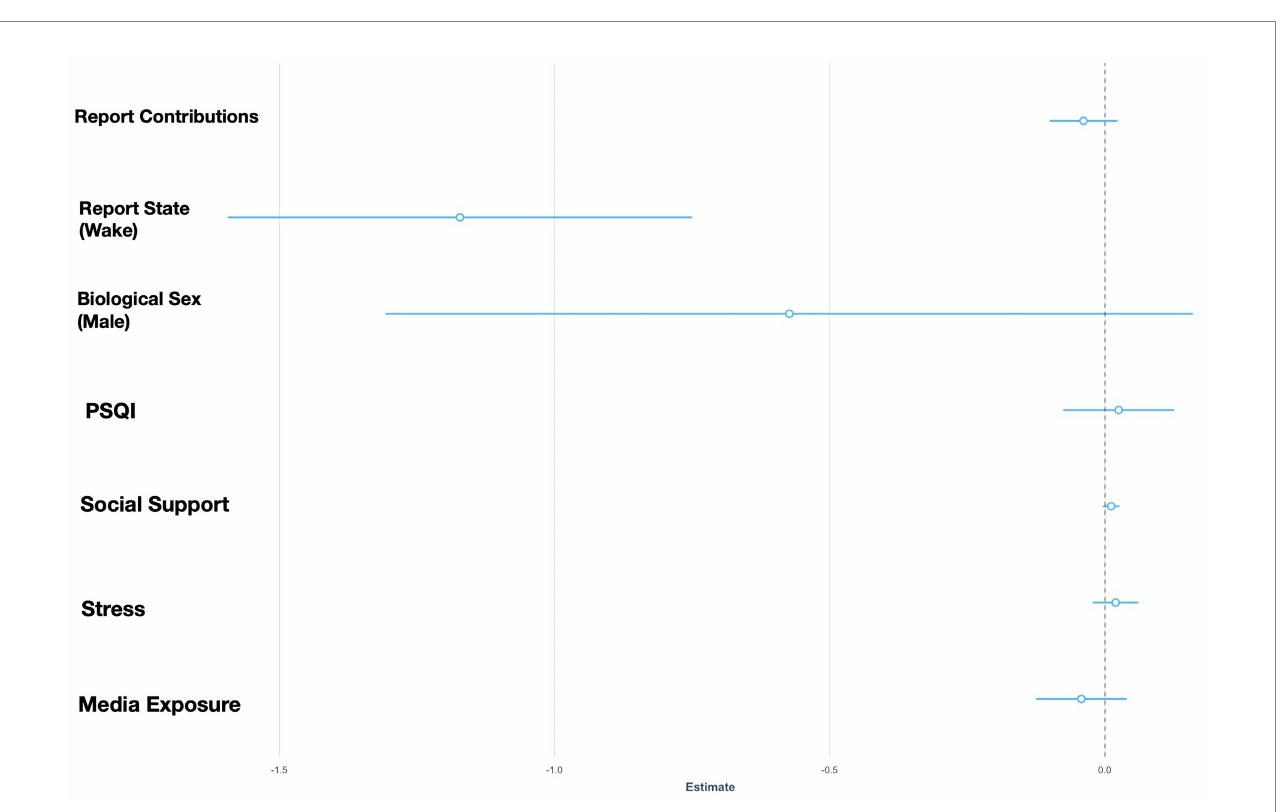
FIGURE 1 Fixed effects plot for GLMM Model 2 with negative social situations as the response